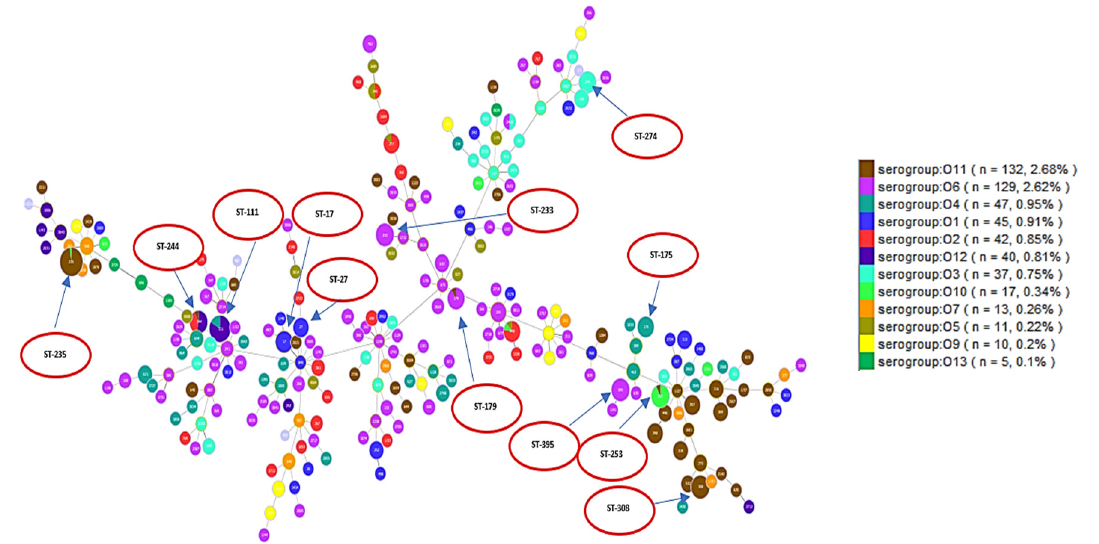
Figure 2. Each serotype is shown in a different color as indicated in the ligand. The figure shows how different serotypes are clustered in relation to different clonal complexes. High-risk clones are shown in red circles.